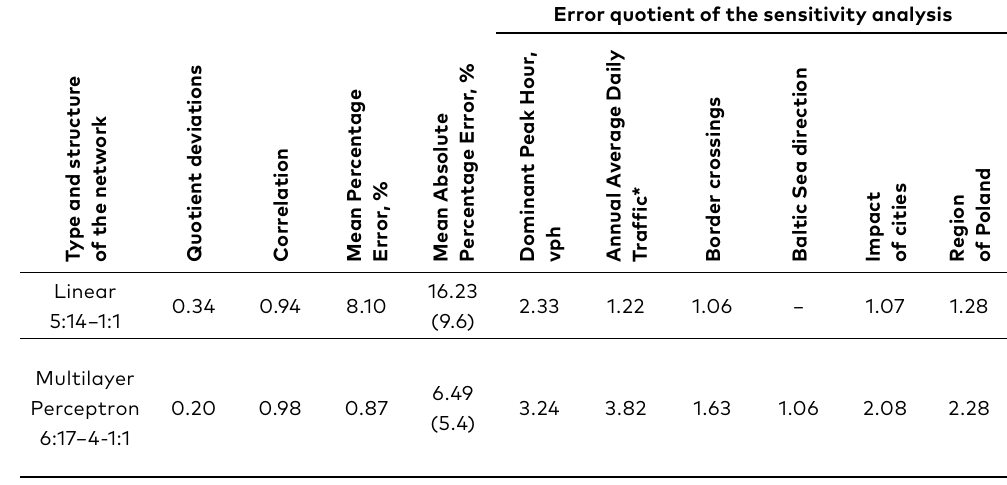
Table 6. Descriptive statistics for the Artificial Neural Network models Error quotient of the sensitivity %